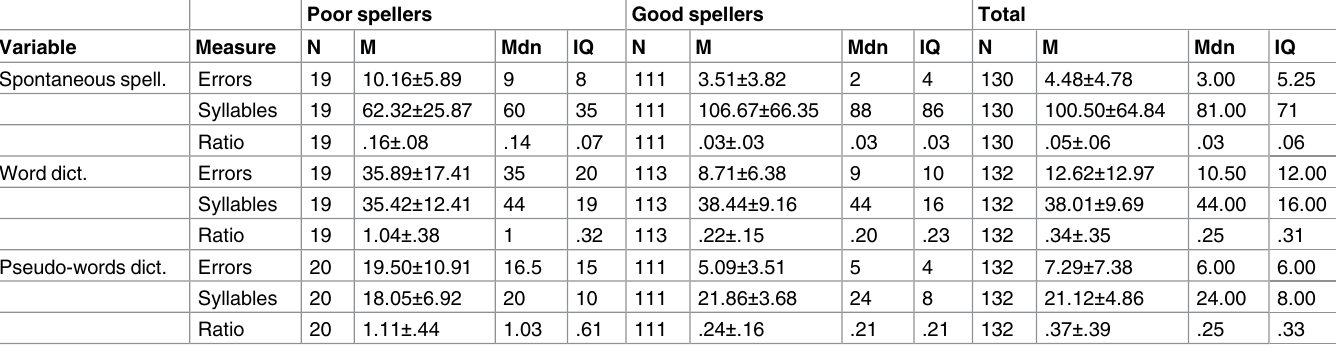
Table 1. Standardized test descriptive statistics: number of participants, mean, standard deviation, median and interquartile